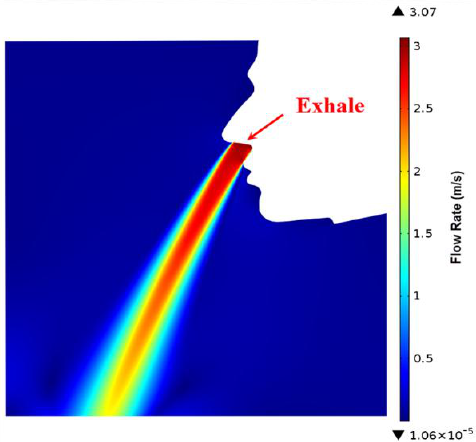
Figure 6. Simulation of human exhalation.